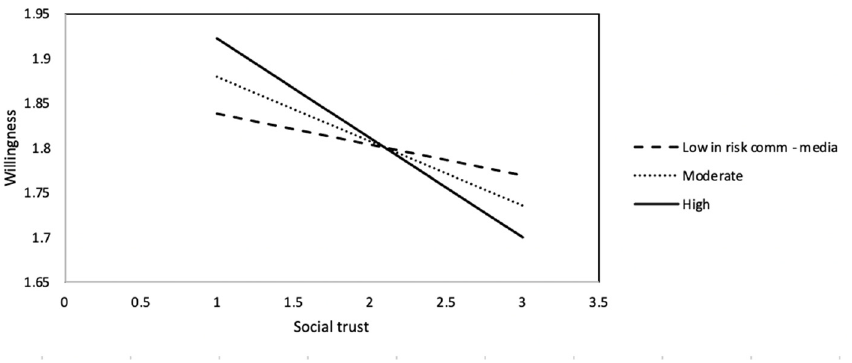
Figure 3. Willingness to socialize with others as a function of social trust and learning about the risks of COVID-19 from the media.